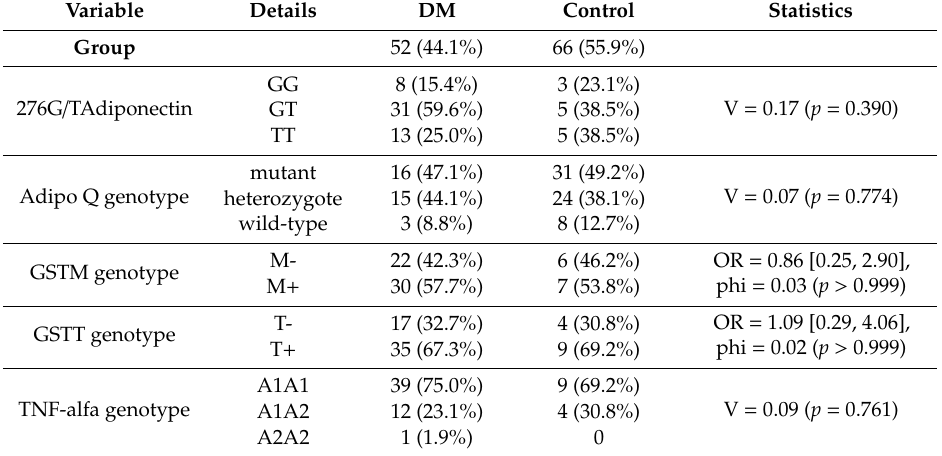
Table 4. Univariate statistics by groups of genotypes for several relevant genes, where available.